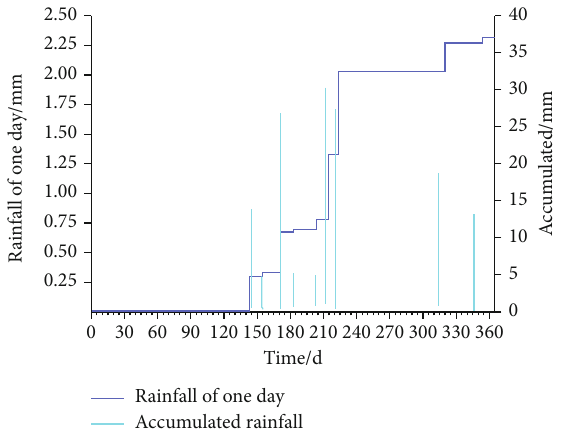
Figure 1: Mogao Grottoes annual rainfall trend.